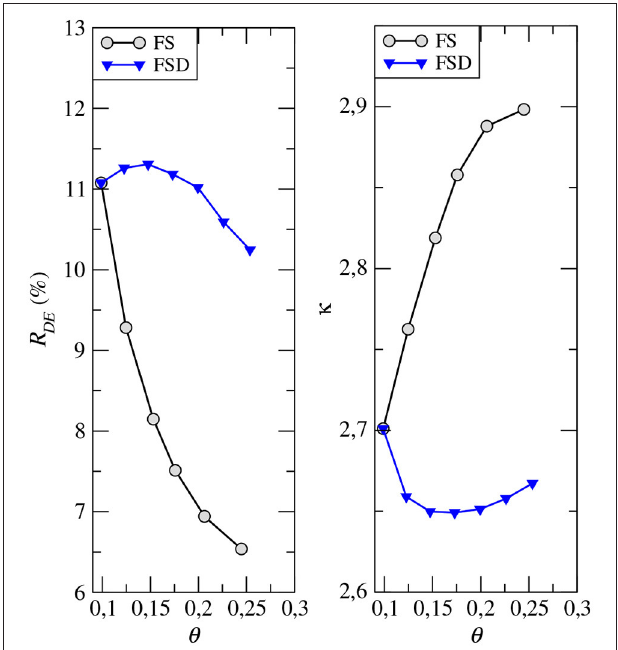
FIGURE 3 | Left : Ratio (in % ) of the number of dead-ends to the number of throats. Right : Mean number of throats per pore κ vs. porosity θ for the FS and FSD samples.